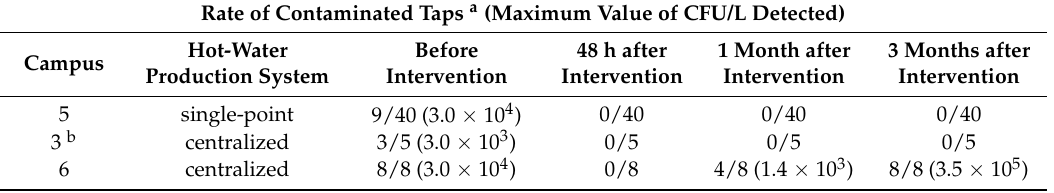
Table 2. Rate of Legionella contamination in the building plumbing system of the University campuses.